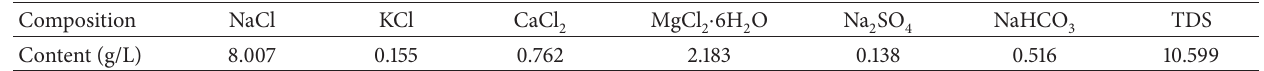
Table 1: TDS and chemical composition of the